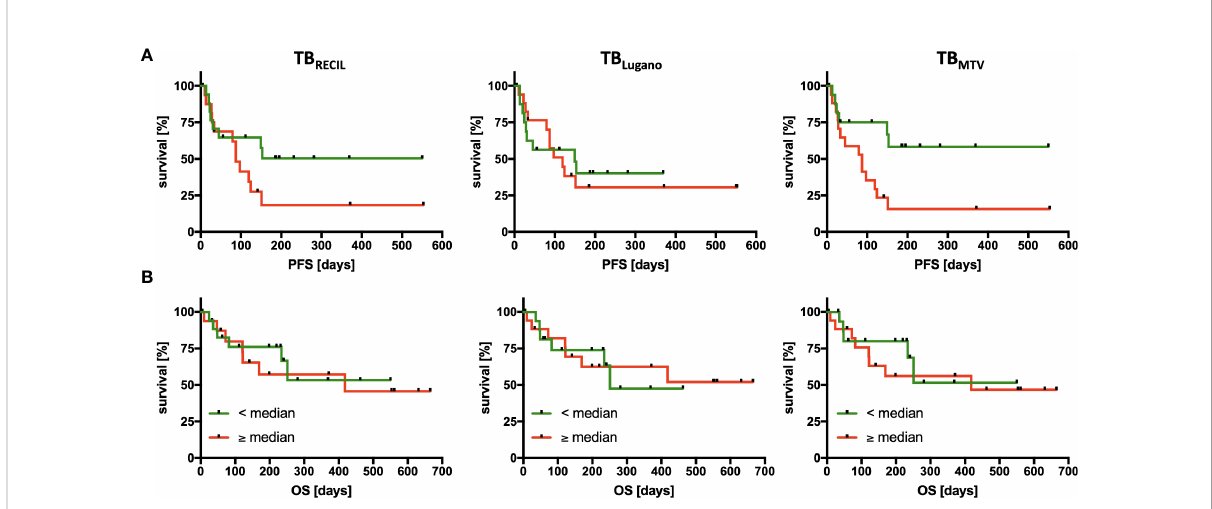
FIGURE 4 Association of Tumor Burden Metrics with Progression-Free and Overall Survival. PFS (A) and OS (B) analysis divided according to the 3 quanti fi cation methods of tumor burden by RECIL (left), Lugano (middle), and metabolic tumor volume (right). The median tumor burden was chosen as cut-off in each case with median baseline TB RECIL 12.5 cm, TB Lugano 4,030 mm 2 and TB MTV 330 mL. Patients with a tumor burden smaller than the median are labeled green and larger than the median are labeled